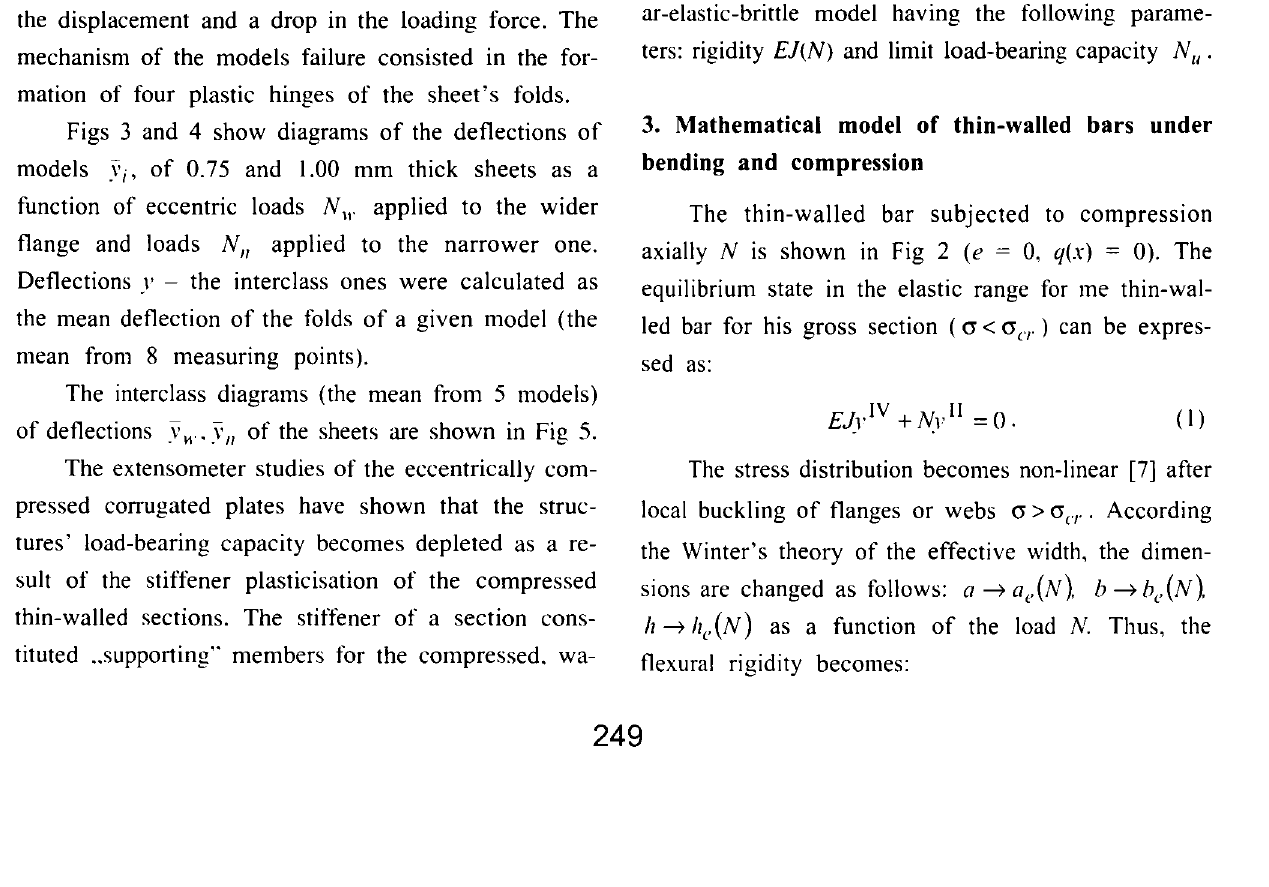
Fig 5. Experimental and numerical deflections of sheets The collapsed fold drops and the redistribution of forces results in the overloading other folds (the ones that have not failed yet) leading to a similar mecha nism of failure in them. The load-displacement curve N(y) of the eccentrically compressed corrugated plates are non-linear functions. These curves are characteri sed by a lack of the plastic stage in the structure's work (in case of compressed thin-walled bars). The load-displacement curves of the eccentrically compres sed corrugated plates can be described by a non-line ar-elastic-brittle model having the following parame ters: rigidity EJ(N) and limit load-bearing capacity N 11